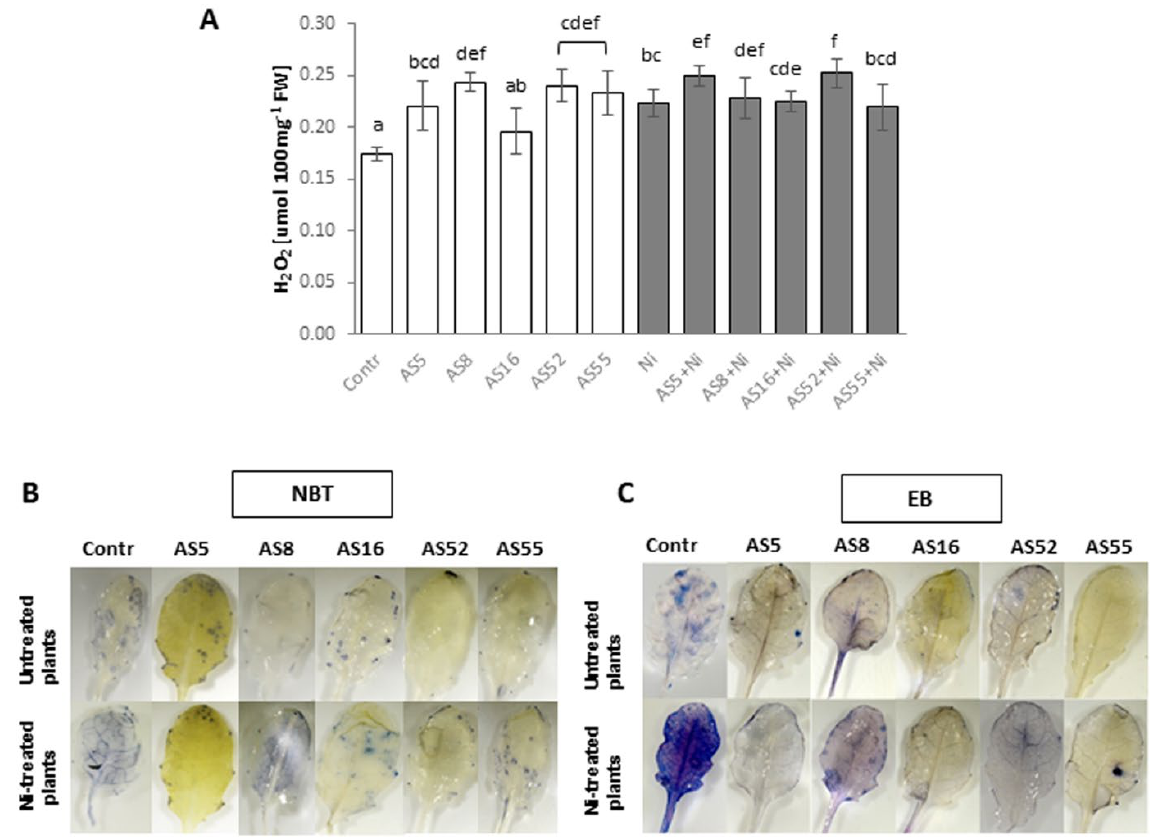
Figure 9. ROS determination and cell death detection in 4-week-old Arabidopsis plants, non-exposed (white bars) and exposed to 200 µ M Ni (grey bars), in the absence or presence of rhizobia. ( A ) H 2 O 2 , hydrogen peroxide content; ( B ) Visualization of superoxide anion accumulation after NBT staining; ( C ) Cell death visualization after Evans Blue (EB) staining (blue color indicates sites of necrosis). Error bars represent ± SD. The same letters indicate the homogenous groups according to the Tukey HSD test at the level p = 0.05.